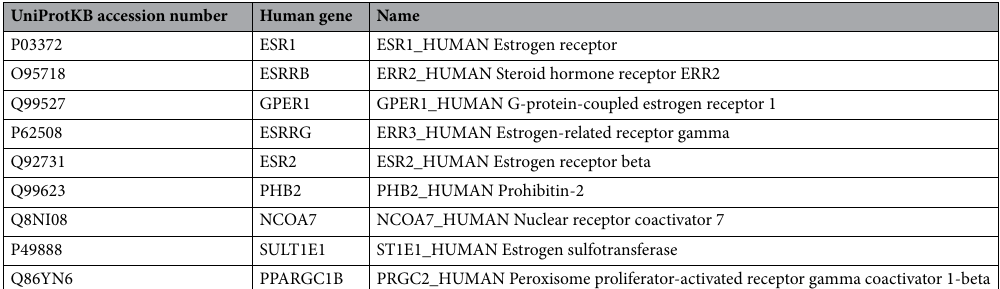
Table 2. List and references of the nine eukaryotic 17β-estradiol binding proteins tested for potential homology to Lactobacillus crispatus CIP104459